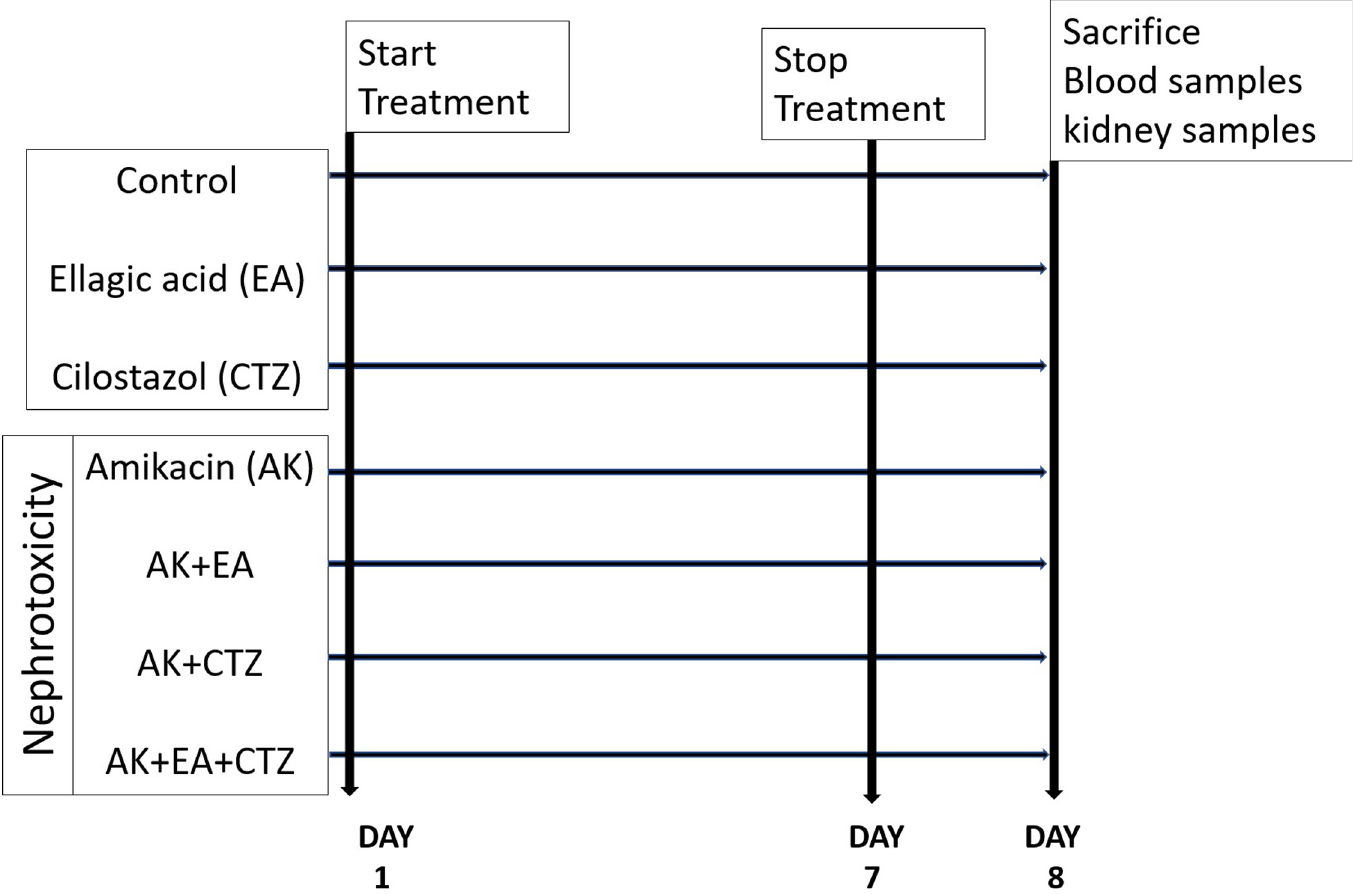
Fig 1. Experimental